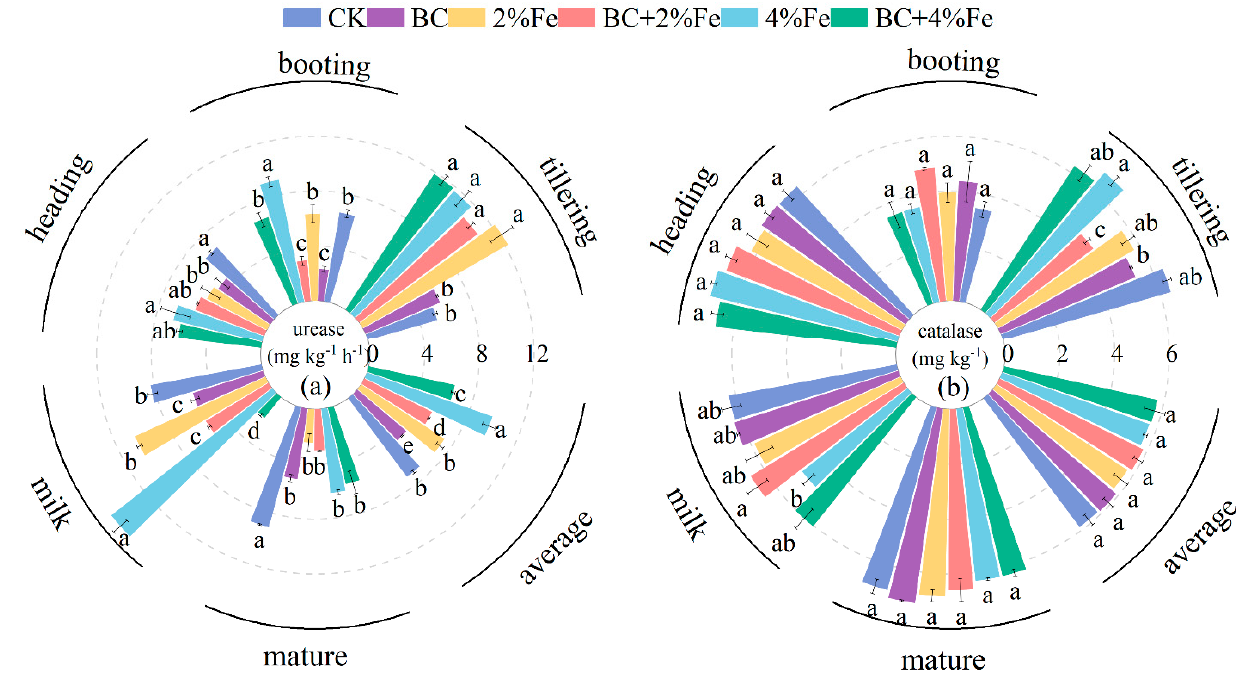
Figure 4. ( a ) Urease activity of paddy field under different treatments during the whole growth stage ( b ) Catalase activity of paddy field under different treatments during the whole growth pe- riod.The data are presented as mean ( ± standard error). Different lowercase letters indicate significant differences between different treatments at p < 0.05.